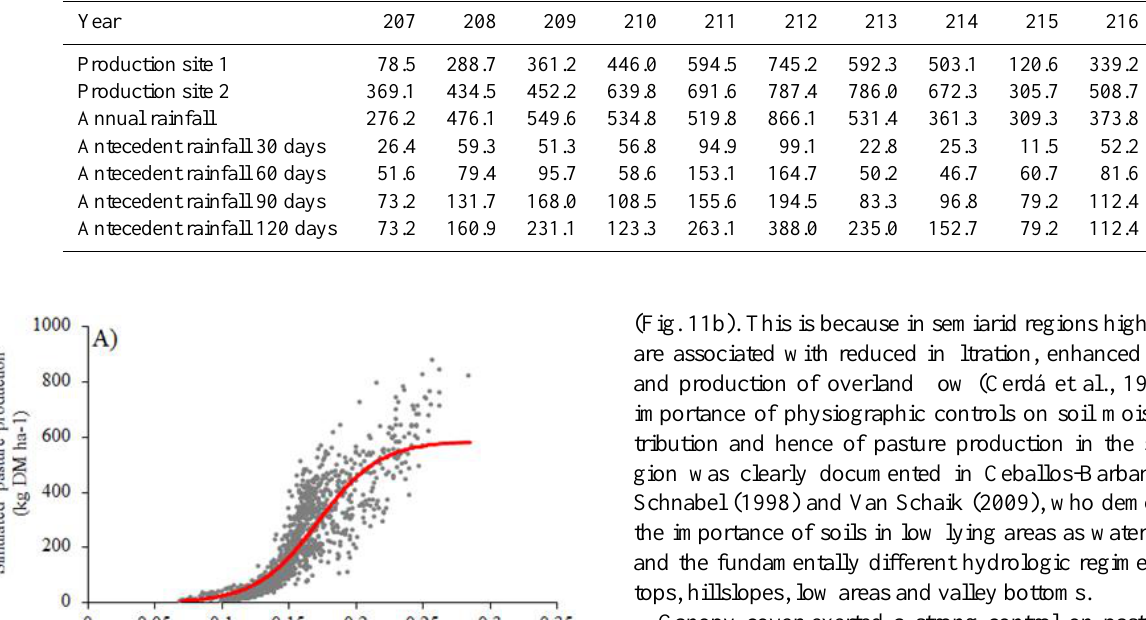
Table 6. Annual pasture production at site 1 and site 2 (kgDMha − 1 ) , annual rainfall (mm) and accumulated antecedent rainfall prior to 1 June (30, 60, 90, 120 days).